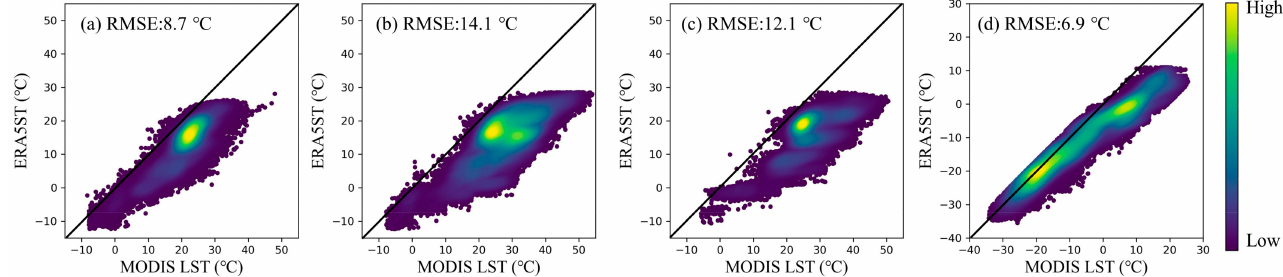
Figure 14. Scatterplots of the MODIS LST and resampled ERA5ST with validation samples for forest ( a ), grassland ( b ), and agriculture land ( c ) in the growing season and all land cover types in the snowing season ( d ). The black line represents the 1:1